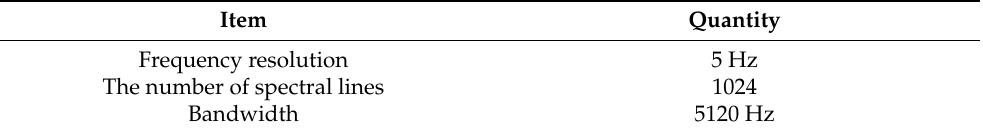
Table 4. Vibration experiment